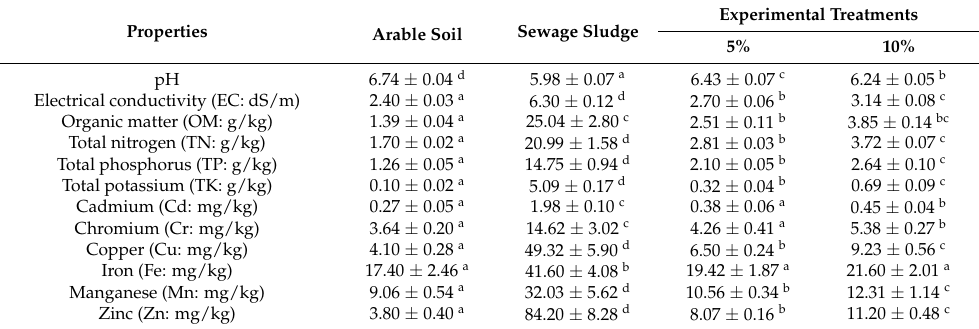
Table 1. Average characteristics of sewage sludge, experimental, and control arable soils used for marigold